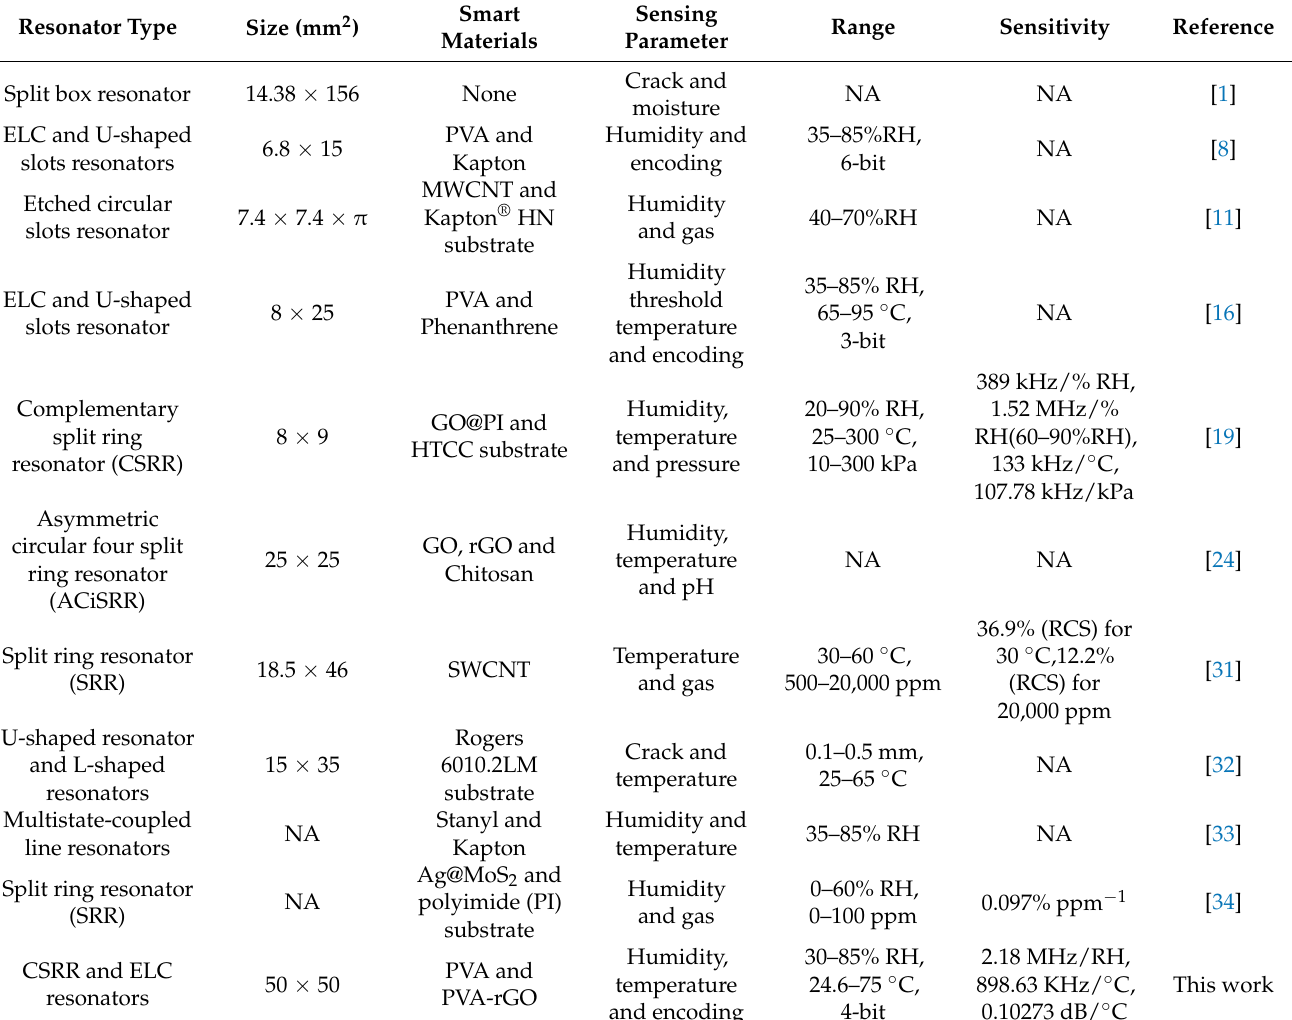
Table 3. Comparison of the proposed tag with other chipless multi-parameter sensors in the